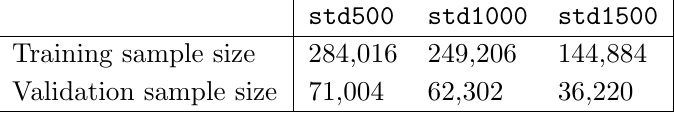
Table 1 . Training sample sizes for std